Question: Which kind of chart has been used to present this data?
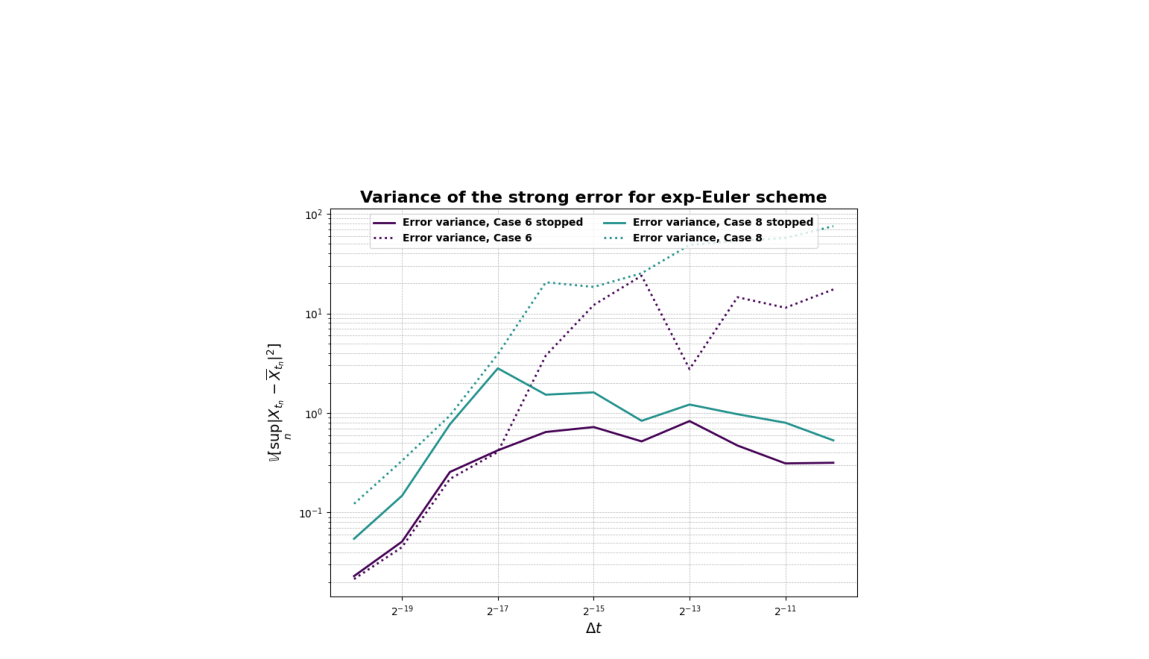
Answer: line